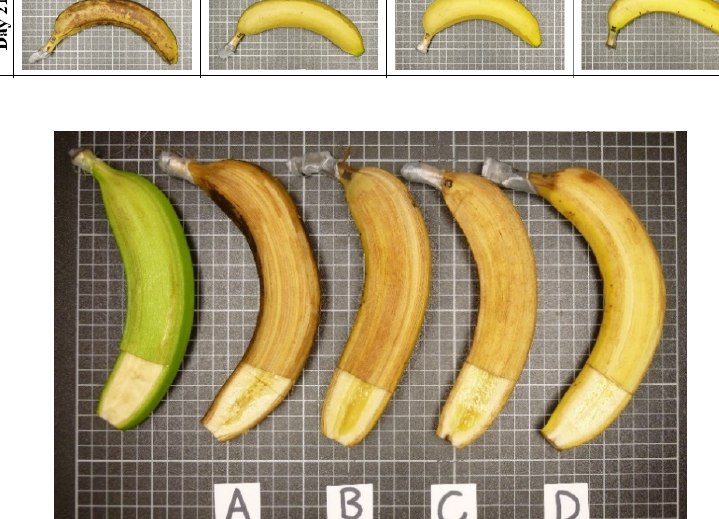
Figure 7. ( Upper figure ) Comparison of the external appearance of untreated green-ripe bananas Figure 7. (Upper figure) Comparison of the external appearance of untreated green-ripe bananas and samples stored at (A) 5 ◦ C, (B) 10 ◦ C, (C) 11.5 ◦ C and (D) 13 ◦ C, and, after ethylene and samples stored at (A) 5 °C, (B) 10 °C, (C) 11.5 °C and (D) 13 °C, and, after ethylene exposed, in shelf life for eight days at 18 °C. ( Lower figure ) Samples (day 21) treated that way after gentle